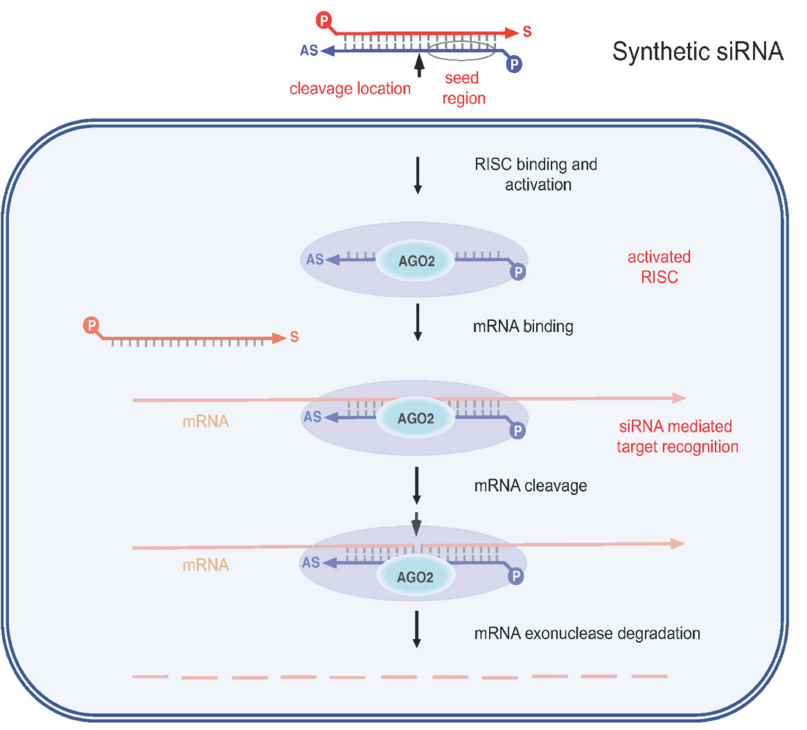
Figure 4. Schematic representation of a siRNA molecule and its interfering function. A given siRNA (top) has a well-defined structure: a short RNA duplex (19–23 bps) with two optional 2 nt overhangs on either 3 (cid:48) -end (frequently DNA), each strand is typically terminated with a 5 (cid:48) -phosphate and a 3 (cid:48) -hydroxyl group. Once introduced inside a cell cytoplasm, an siRNA is strand separated, and the guide strand (antisense, AS, strand in blue) is sequestered by an RNA-induced silencing complex (RISC) in a process involving the RISC Argonaute (Ago) protein (Ago2 in human cells), leading to RISC activation. The siRNA passenger strand (sense, S, strand in red) is discarded and is subsequently degraded. Otherwise, the Ago2 bound siRNA guide strand now enables activated RISC to bind to complementary target mRNA, a process that triggers the selective endo-nucleolytic cleavage of target mRNA, and the e ff ective post-transcriptional knockdown of gene